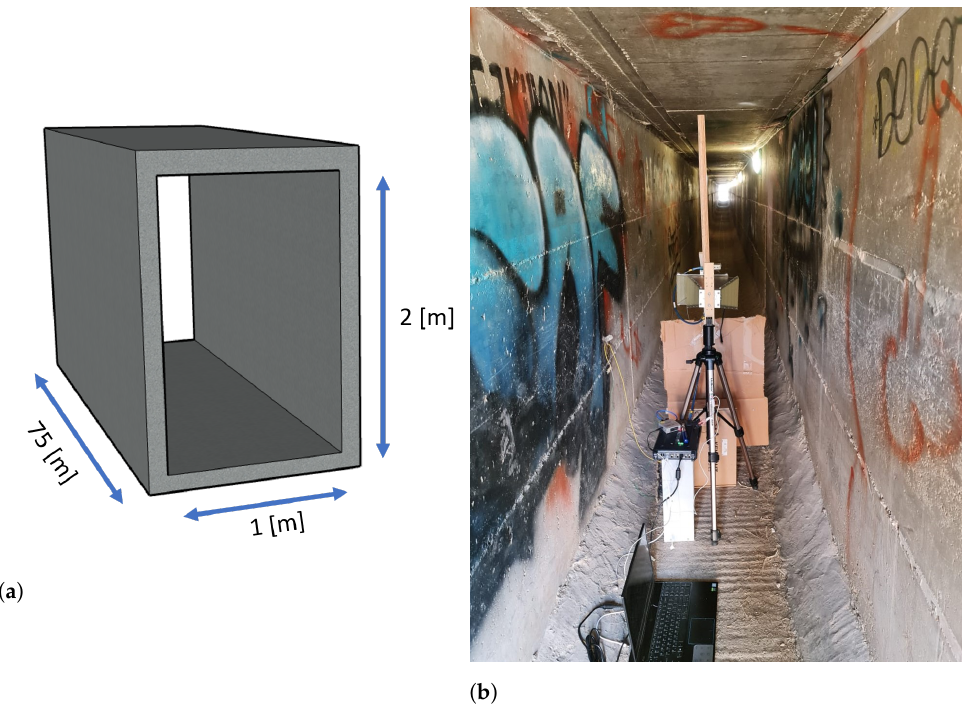
Figure 6. Experiment setup at the experiment site. ( a ) Illustration of the tunnel dimensions. ( b ) A photograph taken at the experiment